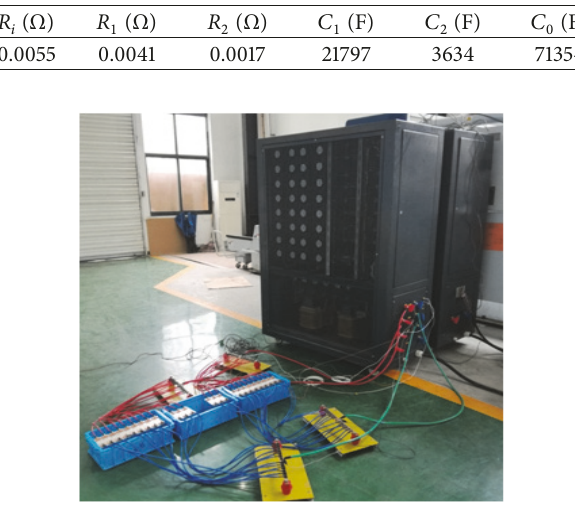
Figure 4: Battery testing device.